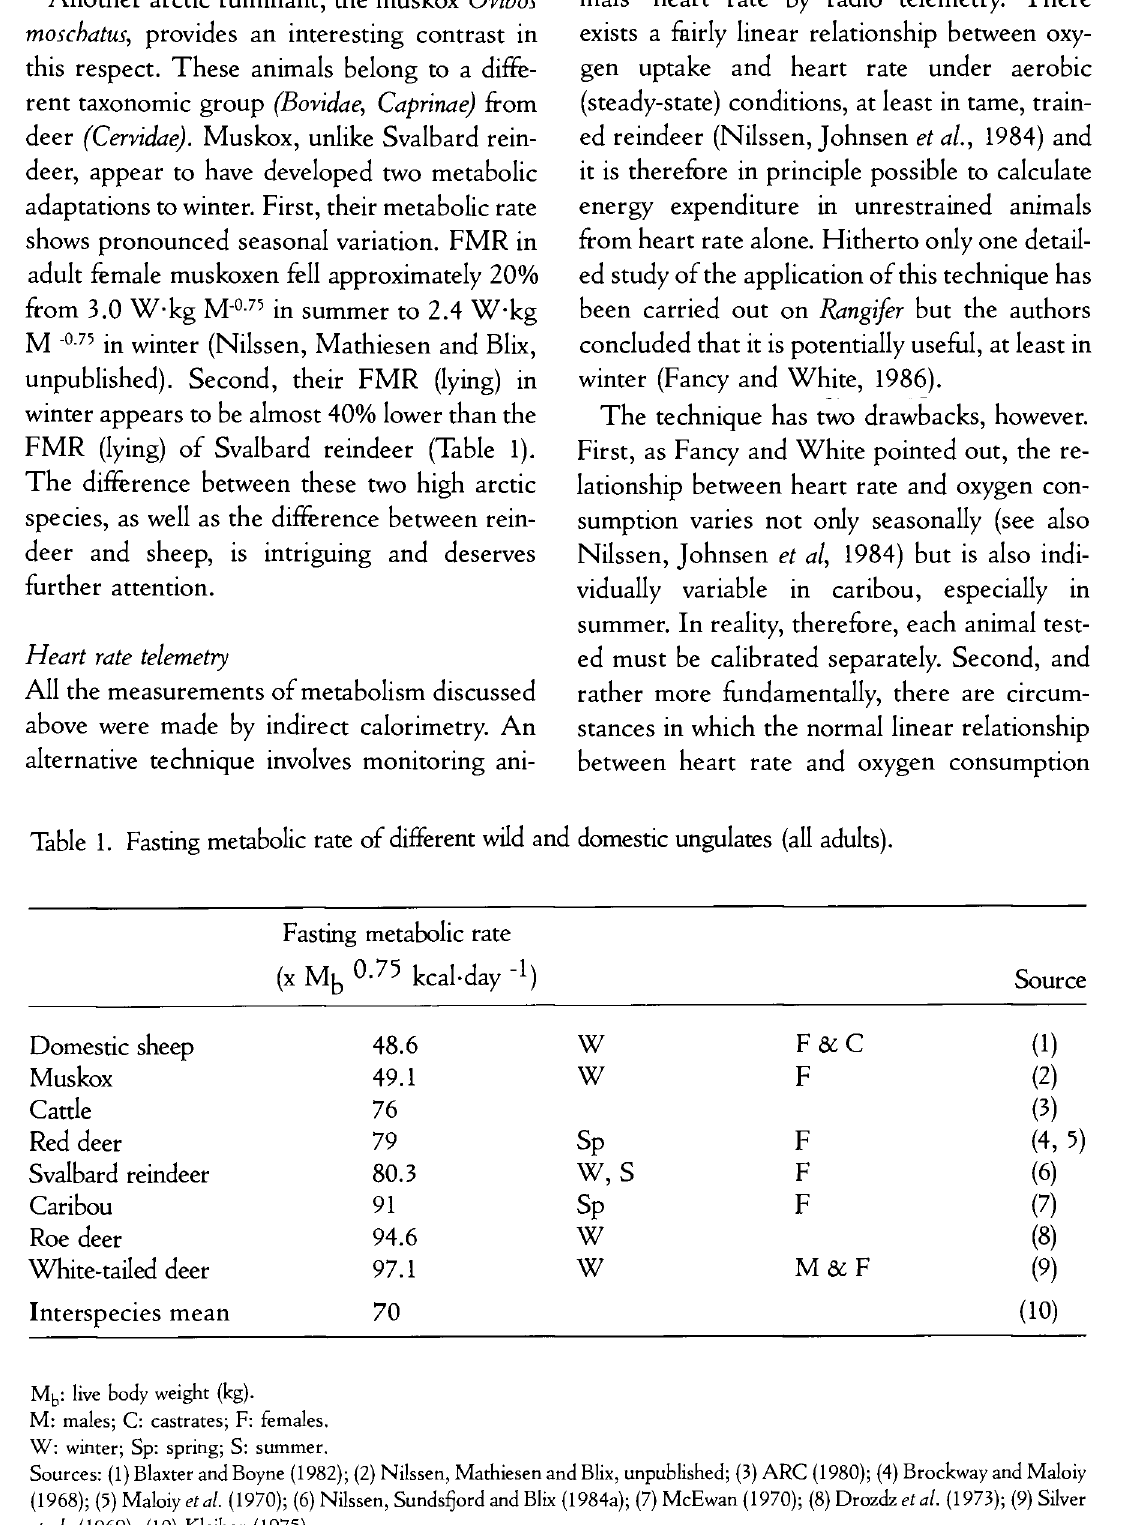
Fasting ; metabolic